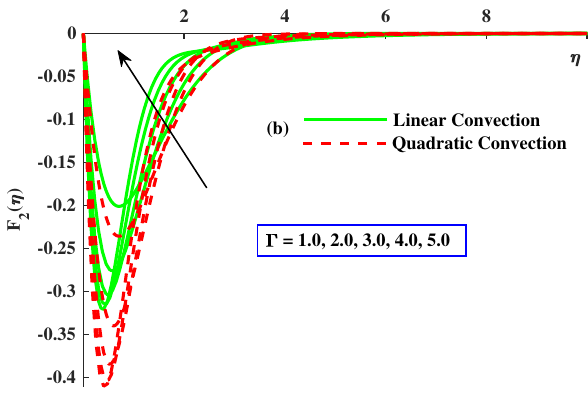
and micro rotation 1